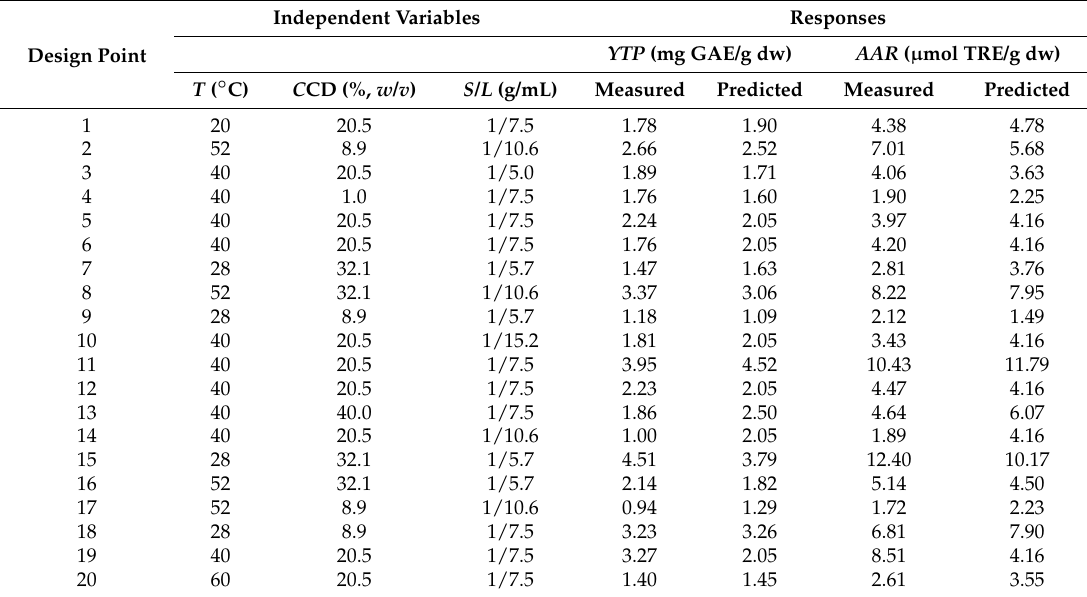
Table 2. Measured and predicted values of extraction yield ( YTP ) and antiradical activity ( AAR ) (extraction for 180 min) determined for the individual design